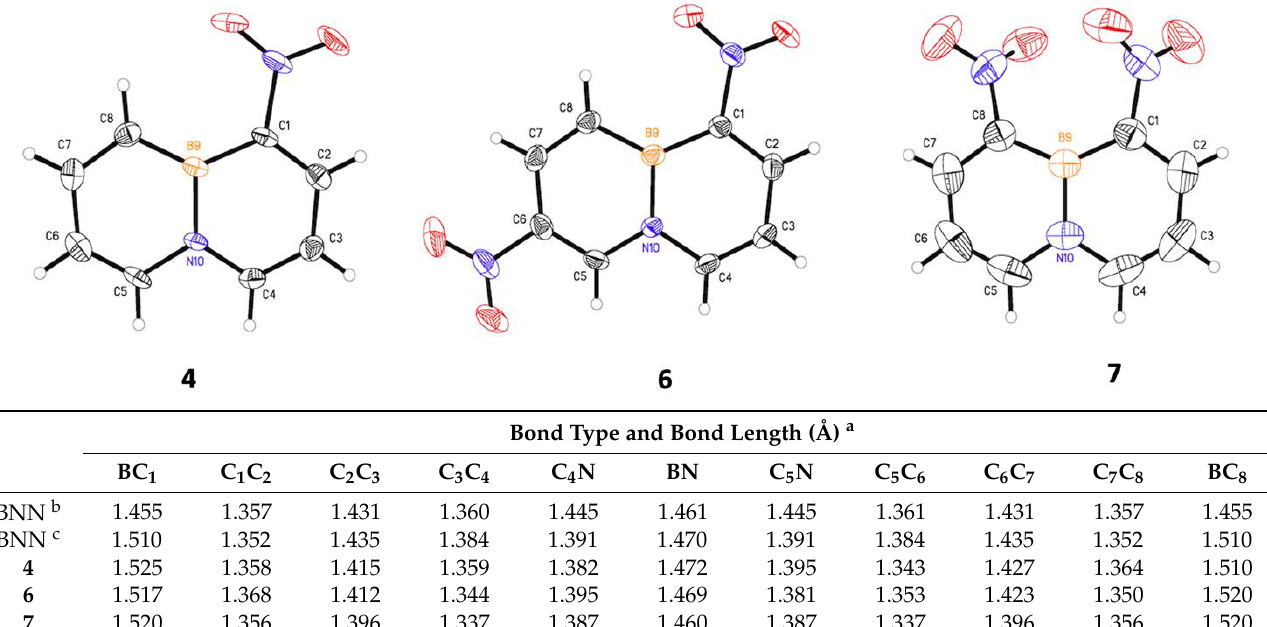
Table 2. Bond lengths of 4 , 6 , and 7 from X-ray crystallographic analysis a .